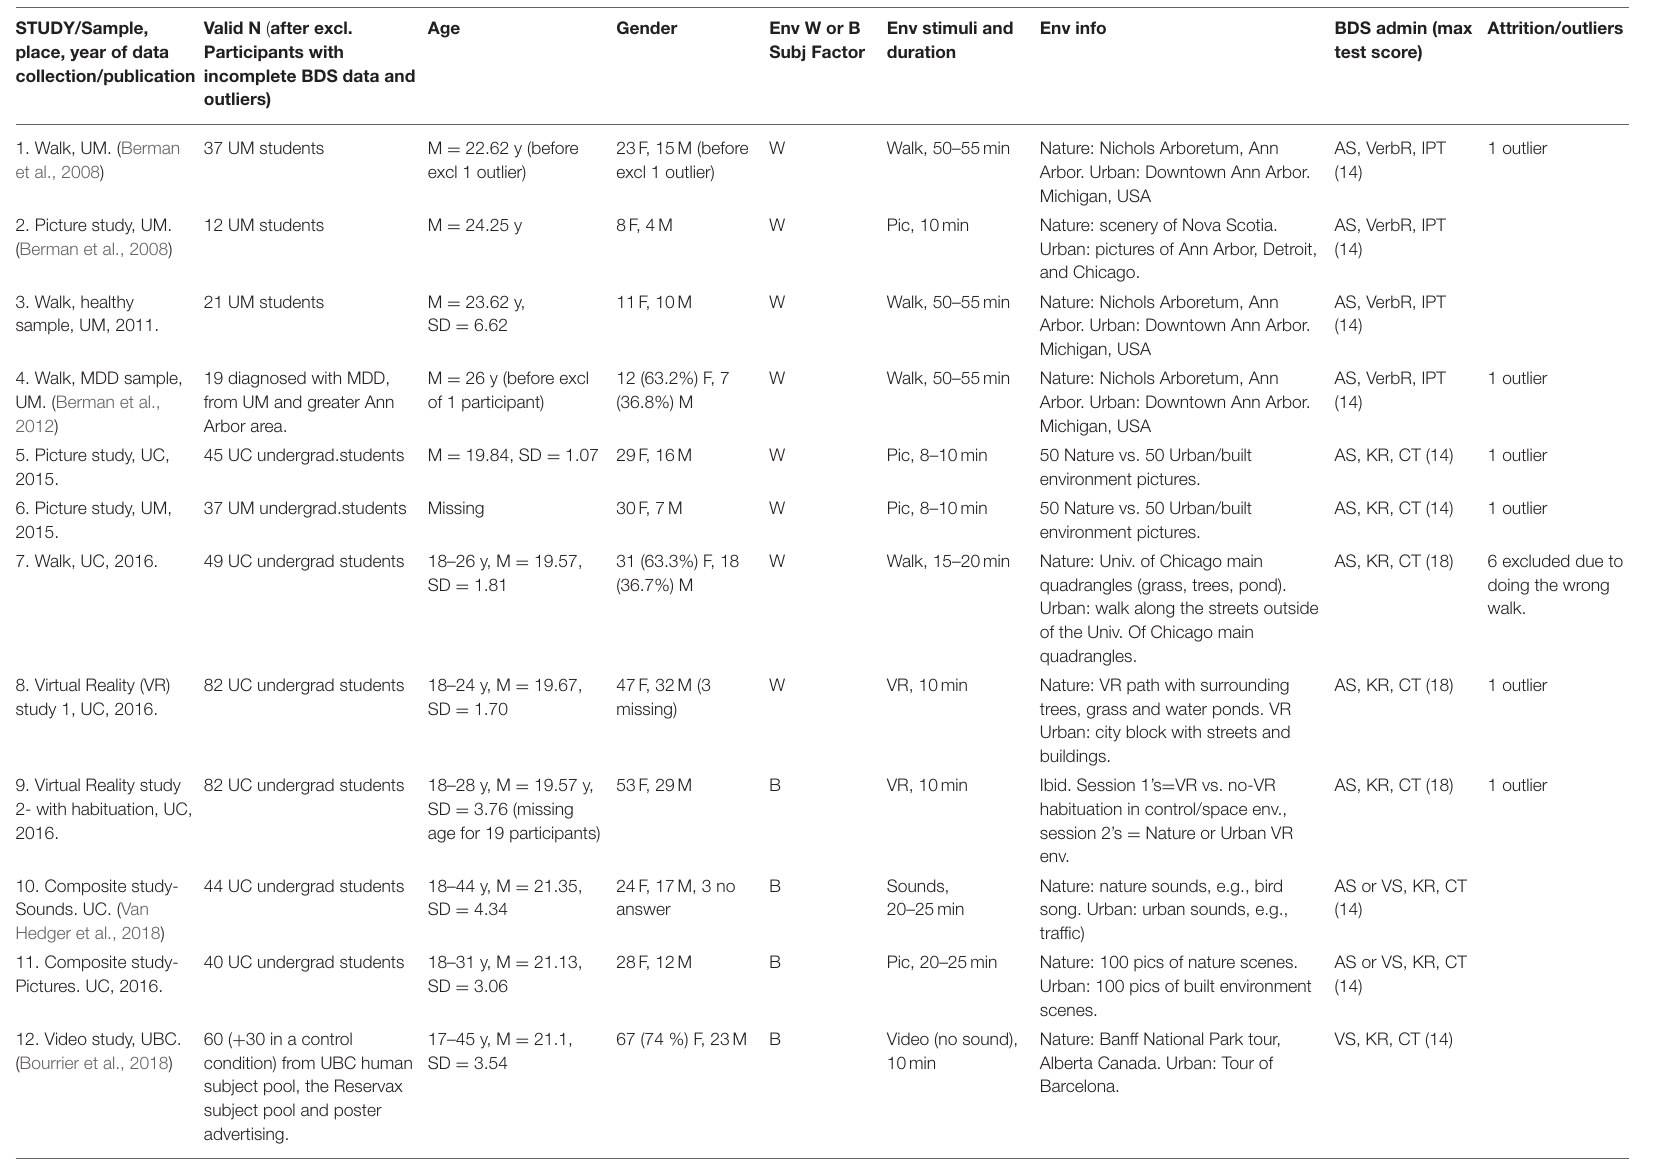
TABLE 1 | Study and sample characteristics. STUDY/Sample, place, year of